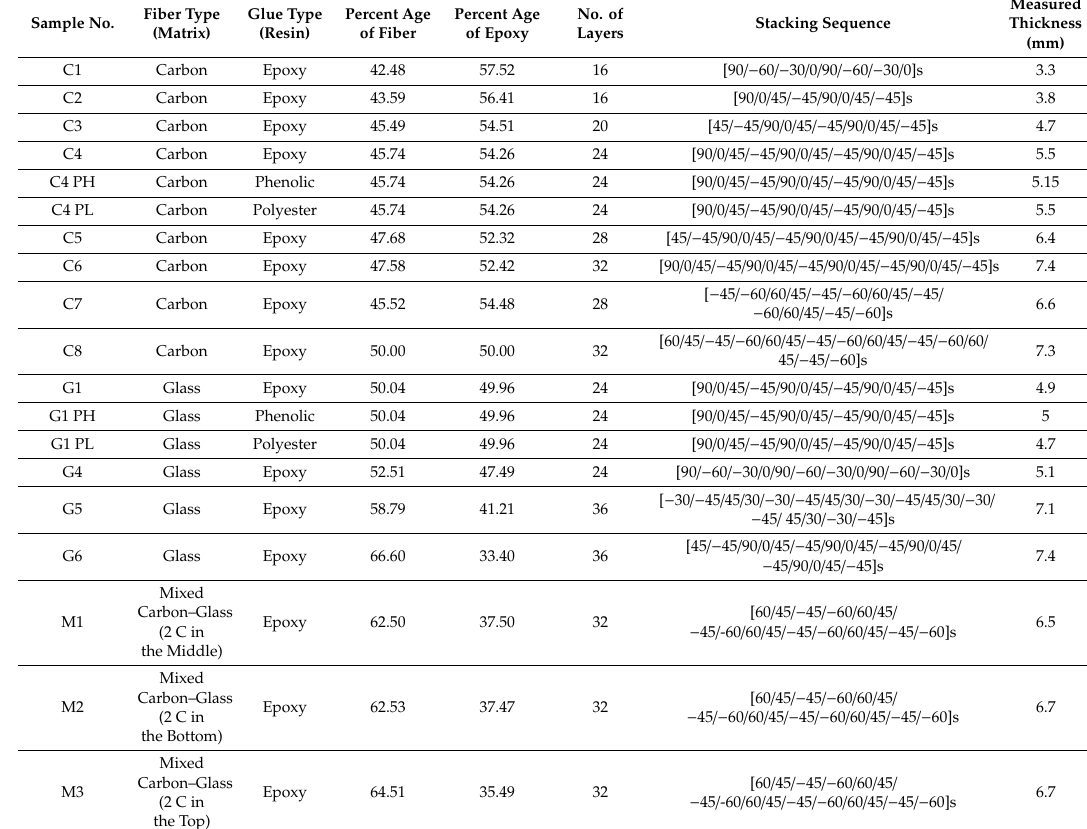
Table 1. Properties of composite